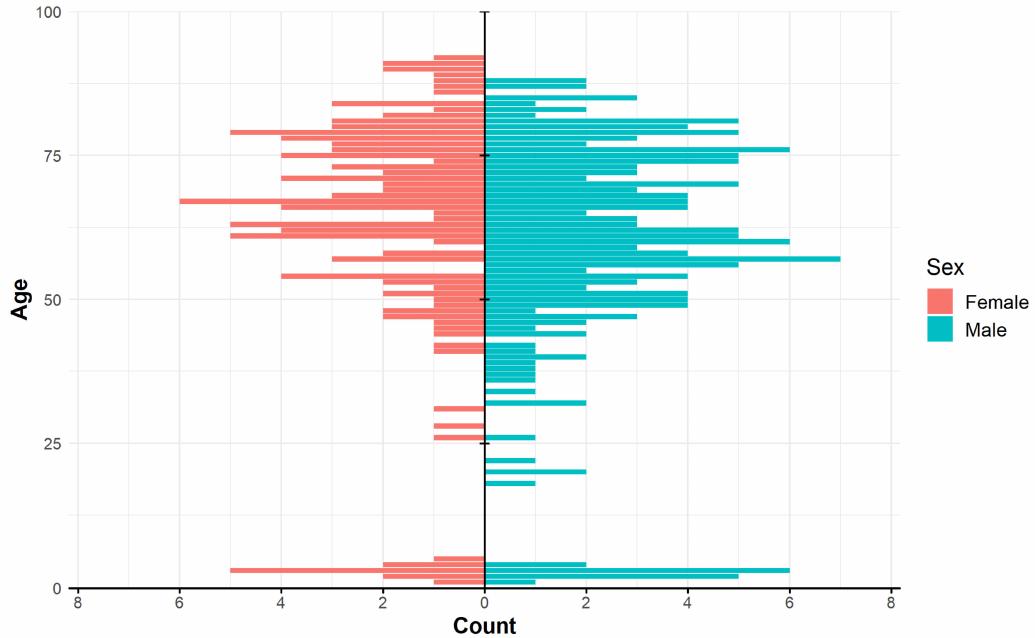
Figure 6. Histogram of NTM diseases by age and sex in the period